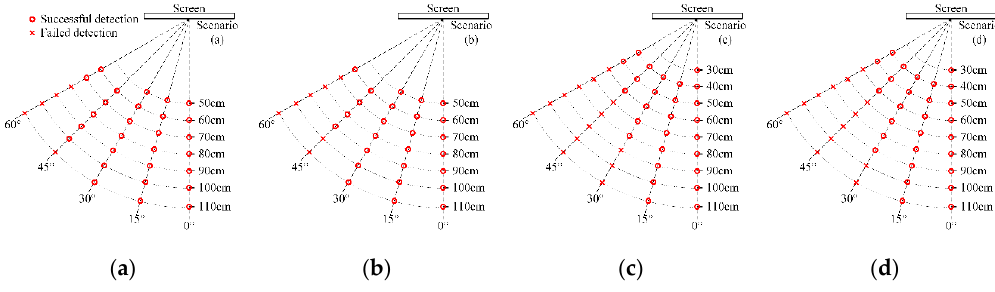
Figure 17. Watermark detection results against screen-cam with common attacks. ( a ), ( b ), ( c ), and ( d ) represent scenarios ( a ), ( b ), ( c ), and ( d ), respectively.